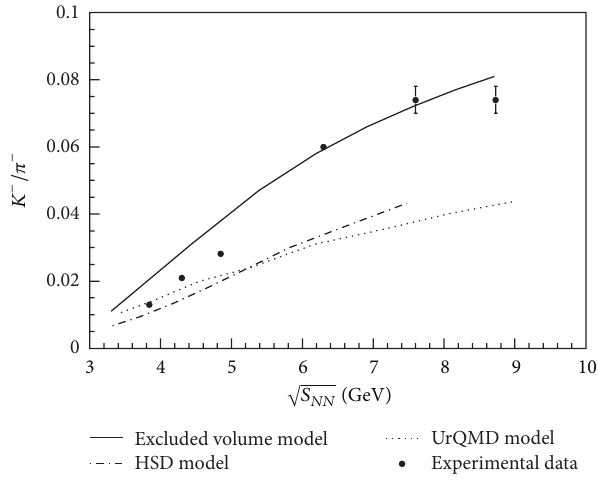
Figure 6: Variation of 𝐾 − /𝜋 − ratio with respect to √𝑠 𝑁𝑁 . The results obtained from HSD and UrQMD are taken from [29]. Experimental data is taken from